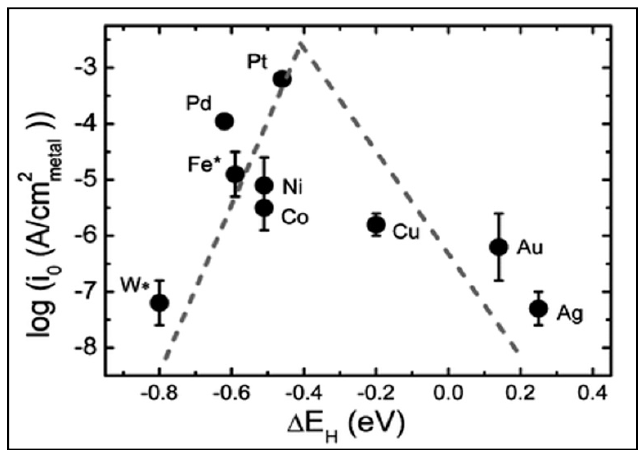
Figure 12. Exchange current densities, log(i 0 ), on monometallic surfaces plotted as a function of the calculated hydrogen binding energy. The data calculated electrochemically for polycrystalline metal disks with a diameter of 5 mm. (*) The data reported for Fe and W were based on the geometric disk area (5 mm in diameter) due to the difficulty in measuring their real surface areas. Reprinted with permission from reference [211]. Copyright 2013 from the Royal Society of Chemistry.